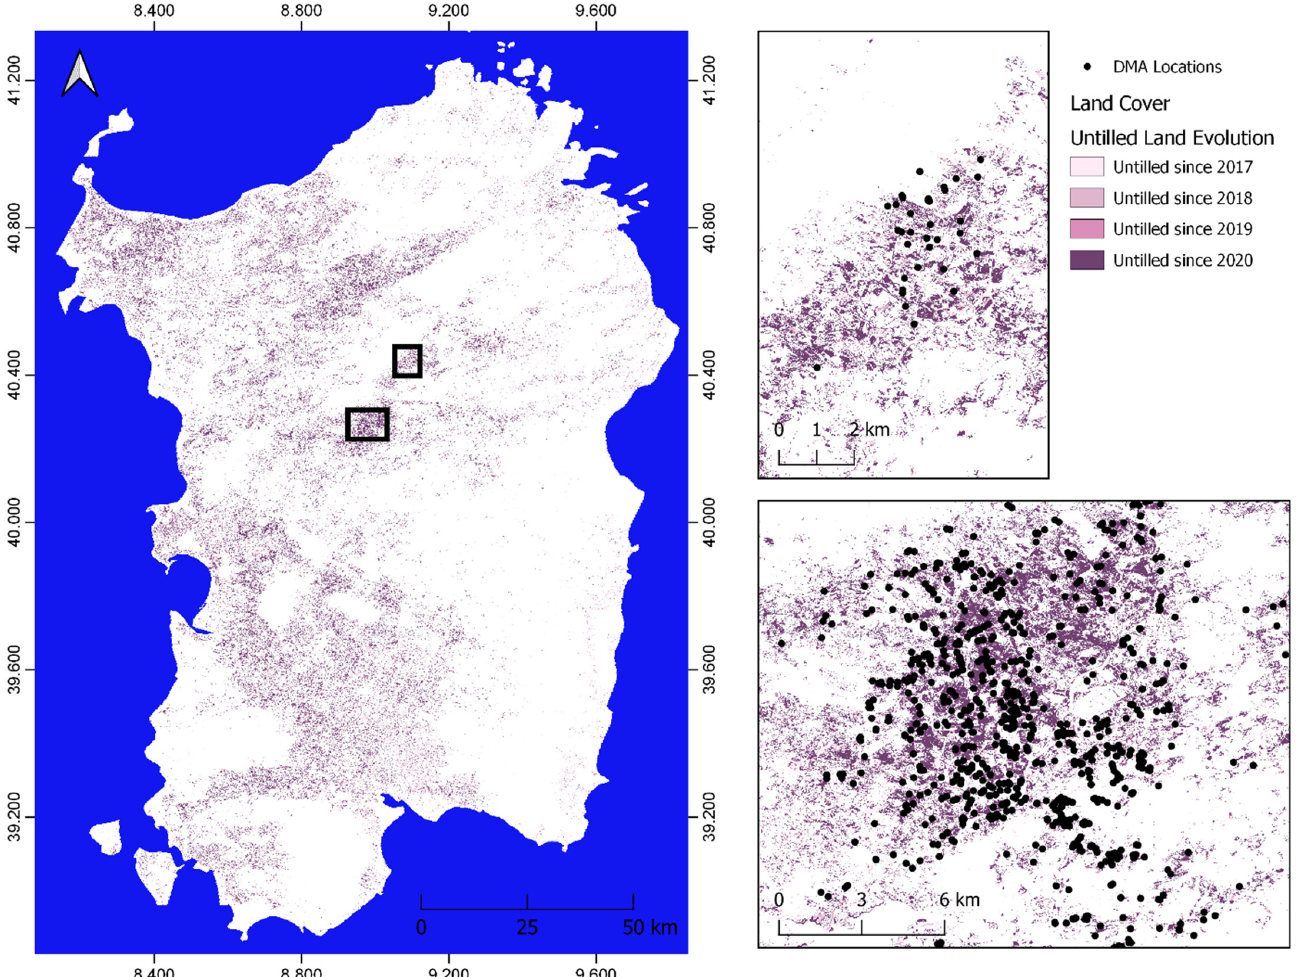
Figure 5. Abandoned land evolution 2017–2020. Zoom areas for region of interest with majority of detected DMA locations.